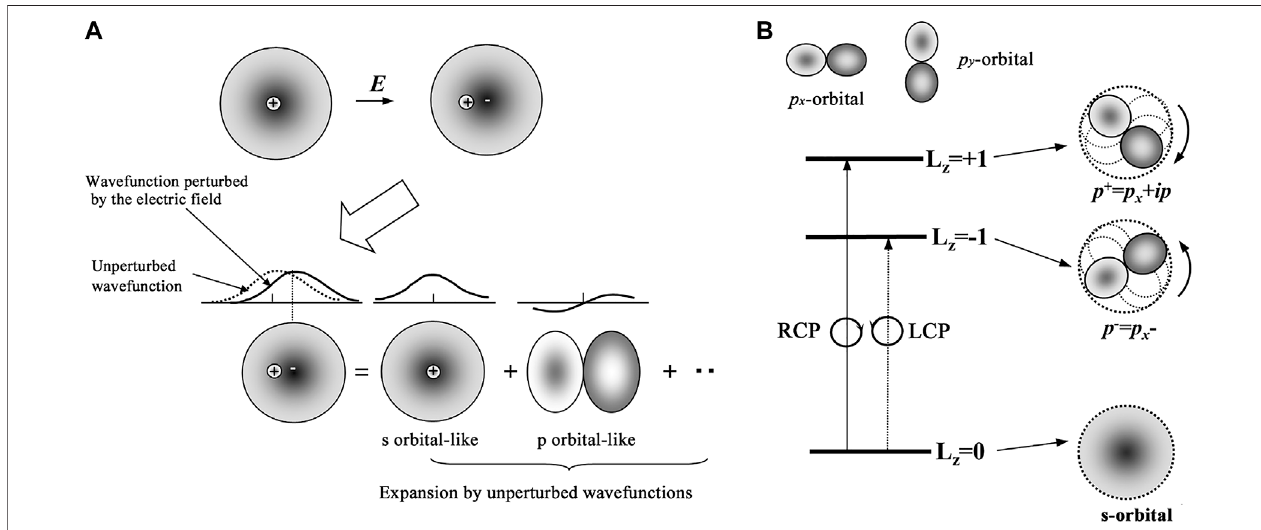
FIGURE 4| (A) The charge distribution of an atom isaltered from an unperturbed state by an applicationof an electric fi eld as a perturbation, producingan electric dipole moment. (B) Schematic illustration explaining the origin of the magneto-optical effect. Angular distribution of electron for Lz = ±1 is considered p-electron-like and can be expressed as p ± = p x ± ip y expressing right-hand rotation and left-hand rotations of p-like distribution around the z-axis. This means circularly polarized light induces rotation of electrons.